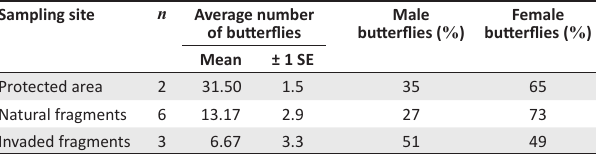
FIGURE 2: Means (±SD) of total observed butterfly behavioural incidences, as well as the incidences in each behavioural classification, in the Grootvadersbosch Nature Reserve forest ( n = 2), the natural forest fragments ( n = 6) and the forest fragments invaded by Acacia mearnsii ( n = 3). TABLE 1: The average number of Charaxes xiphares occidentalis individuals that entered a sampling radius (as a proxy for abundance) from which behavioural data were recorded, as well as their sexual delineation.